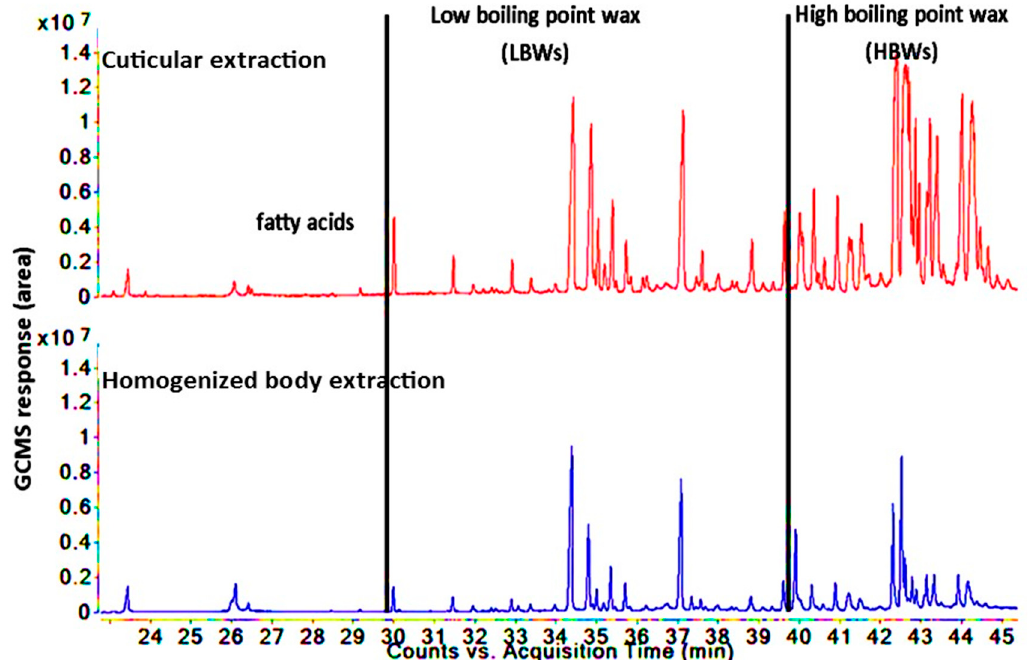
Figure 1. Total signal chromatogram of lipids of cuticular extraction followed by homogenized body extraction of same insects of Tribolium castaneum, using acetonitrile as solvent.